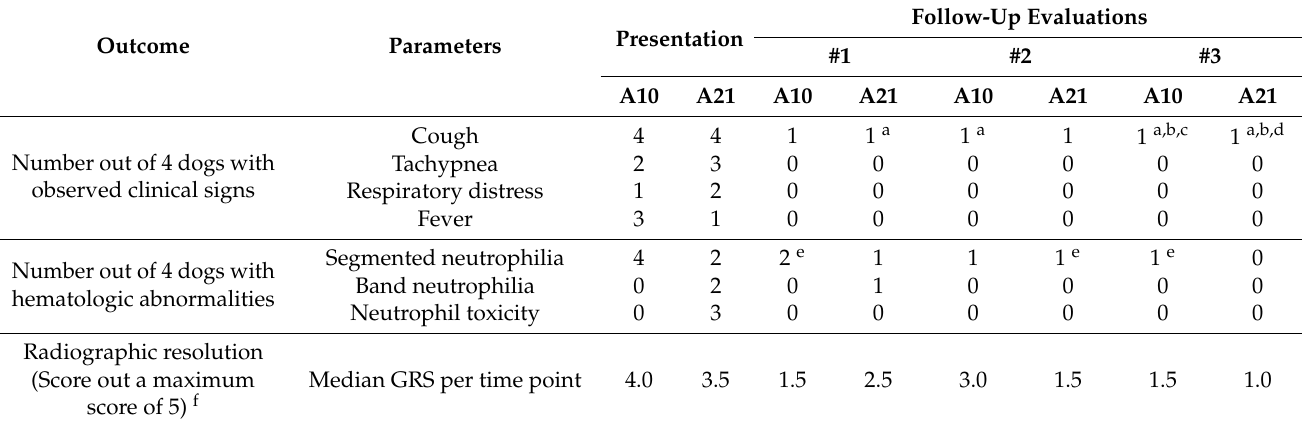
Table 4. Time course of the resolution or persistence of clinical signs, hematologic abnormalities and radiographic lesions in 8 dogs receiving short or long courses of antibiotics ( n = 4/group). Outcome parameters are reported in each group at presentation and follow-up visits. A10, patients received 10 days of antibiotics; A21, patients received 21 days of antibiotics; GRS, global radiographic